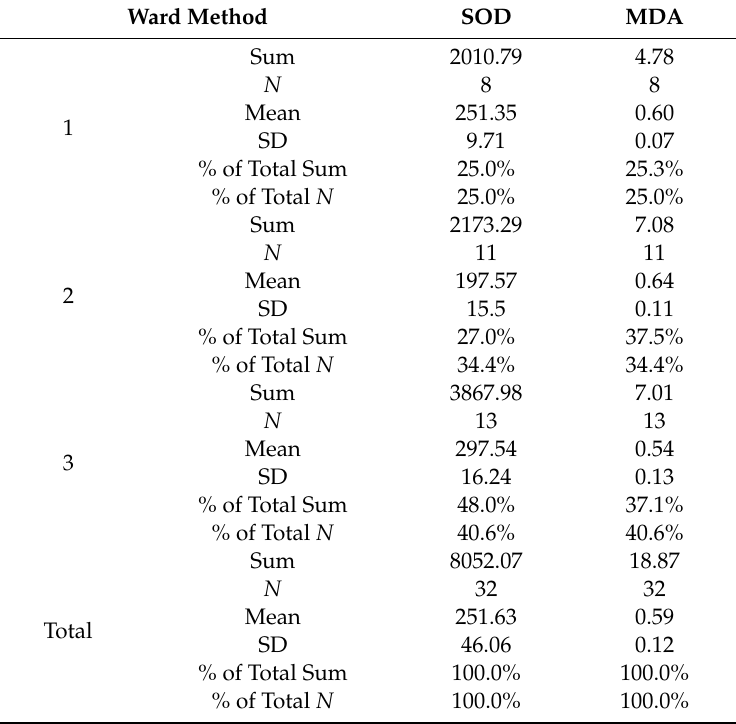
Figure 7. The phytochemical contents, ferric-reducing antioxidant power (FRAP), Trolox equivalent antioxidant capacity (TEAC), and total phenolic content in 14 teas are presented in Tables 3 and 4. The results of the other 18 teas can be found in our previous paper on the in vitro antioxidant activities of teas [16]. A total of 16 phytochemicals were identified and quantified, including GC, EGC, C, EGCG, EC, GCG, ECG, and CG, gallic acid, chlorogenic acid, ca ff eine, ellagic acid, quercitrin, astragalin, addition, EC (31), EGCG (28), ECG (26), EGC (24), GC (22), EA (22), GCG (21) were found in most